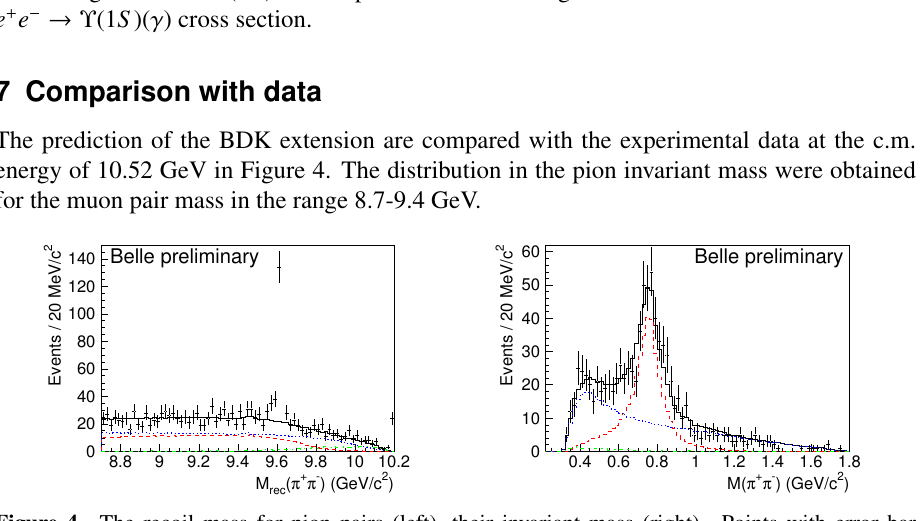
Figure 4. The recoil mass for pion pairs (left), their invariant mass (right). Points with error bar represent preliminary Belle data [3], red lines show simulated contributions of e + e − → 2 π 2 µ , green and blue lines are for contributions of misidentified muon and electron pairs, respectively. The black lines show the sum. The peaks at 9.6 and 10.2 GeV are reflections of the transition between narrow Υ states, which was not